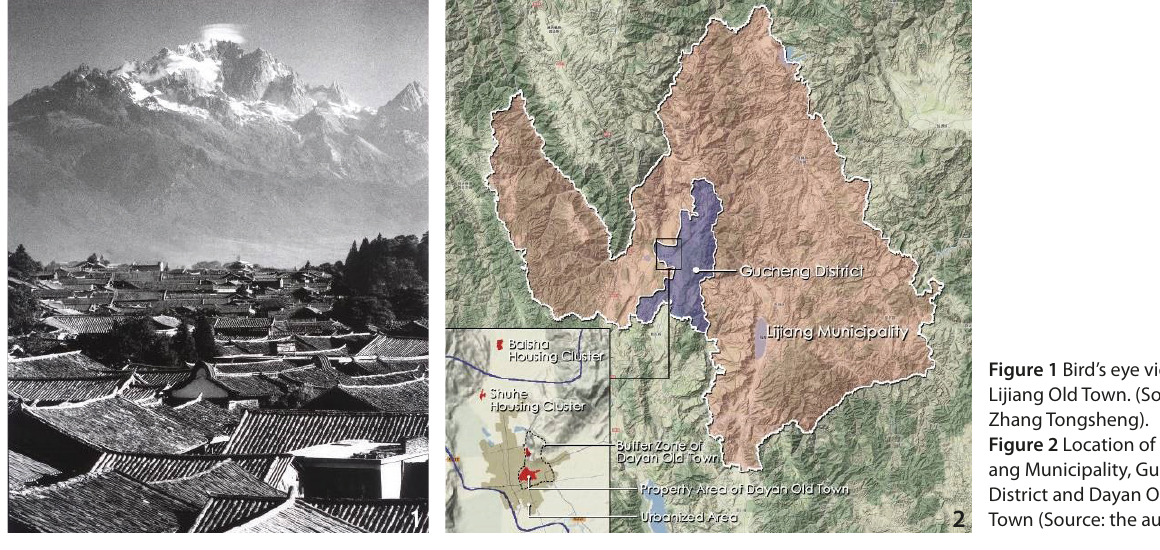
Figure 1 Bird’s eye view of Lijiang Old Town. (Source: Zhang Tongsheng). Figure 2 Location of Liji- ang Municipality, Gucheng District and Dayan Old Town (Source: the author).